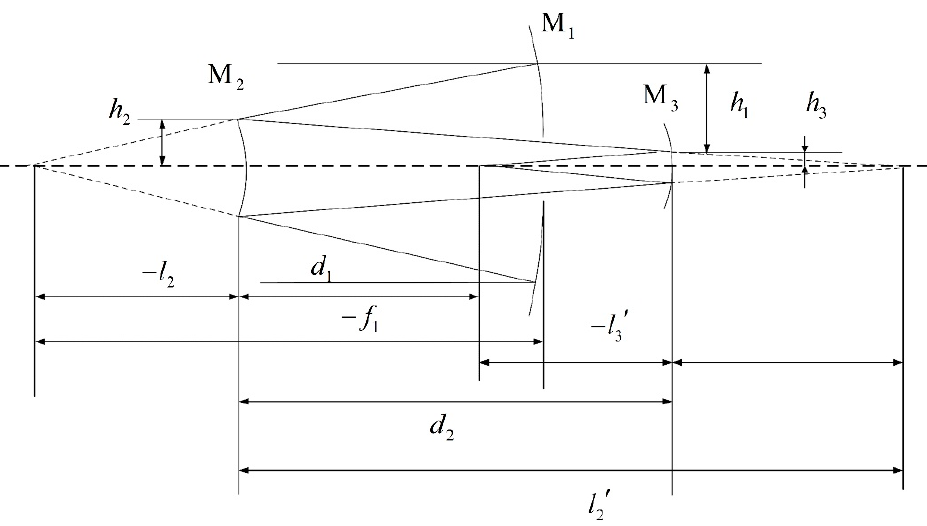
Figure 7. Sketch of the off-axis three-mirror reflective system.